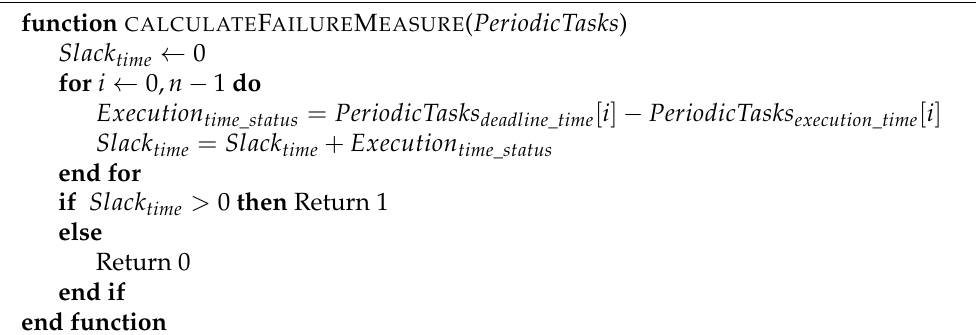
Algorithm 1 Calculation of Failure Measure for Scheduling of Periodic